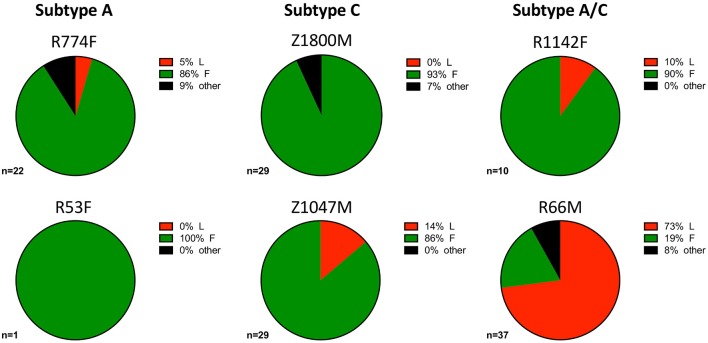
VH1-69 polymorphisms at amino acid 54 within complementarity-determining region-2 (CDRH2). The frequency of 51p1-like 54F (green), hv1263-like 54L (red), and other amino acids in six individuals infected with Subtype A (left column), Subtype C (center column), and Subtype A/C unique recombinants (right column) is illustrated. The 54F polymorphism was dominant except for R66M (bottom right), where 54L was present in the majority of the anti-gp120 VH1-69 sequences and R53F where only one VH1-69 sequence was present. A minority of VH1-69 sequences contained “other” amino acids (black) at this position in three individuals: R774F, Z1800M, and R66M. The total number of VH1-69 sequences analyzed for each individual is shown. Raw values are reported in Supplementary Table 2.